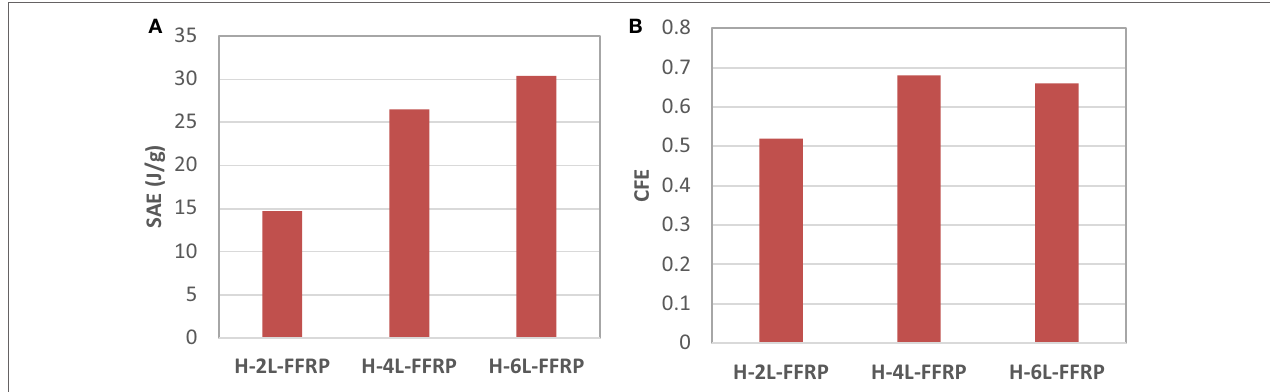
FigUre 5 | Effect of number of flax fabric layers on specific absorbed energy (SAE) (a) and CFE (B) of hollow flax FRP (FFRP) tubes.